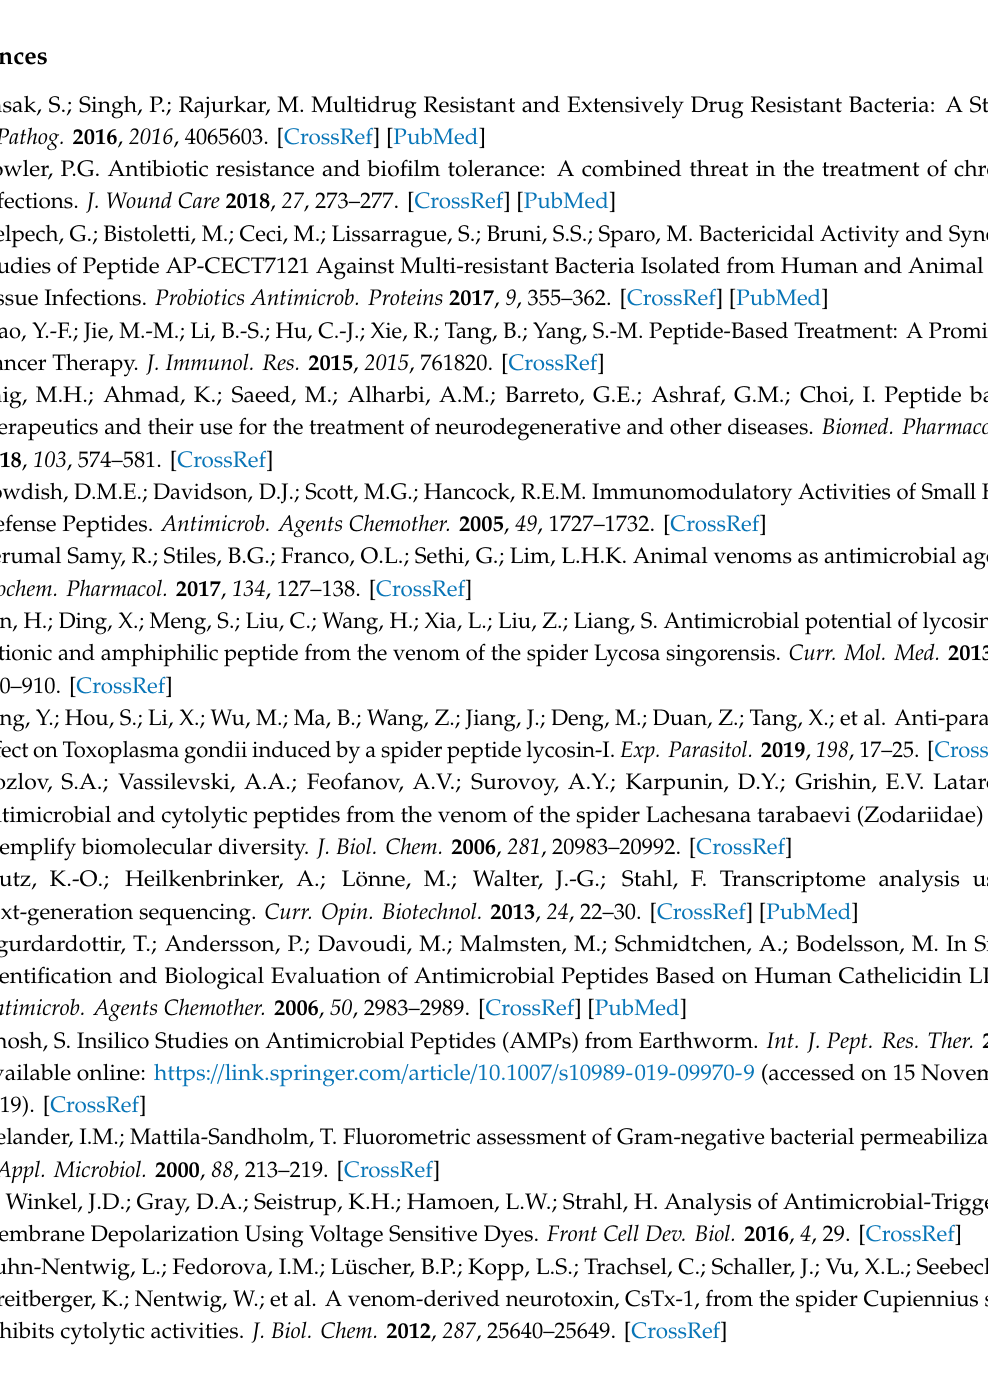
Figure S1: Quality control of synthesized TBIU005495 was performed via HPLC and MS. HPLC profile (A) and MS chromatogram (B) of TBIU005495 was shown. The peptide was collected with purity >